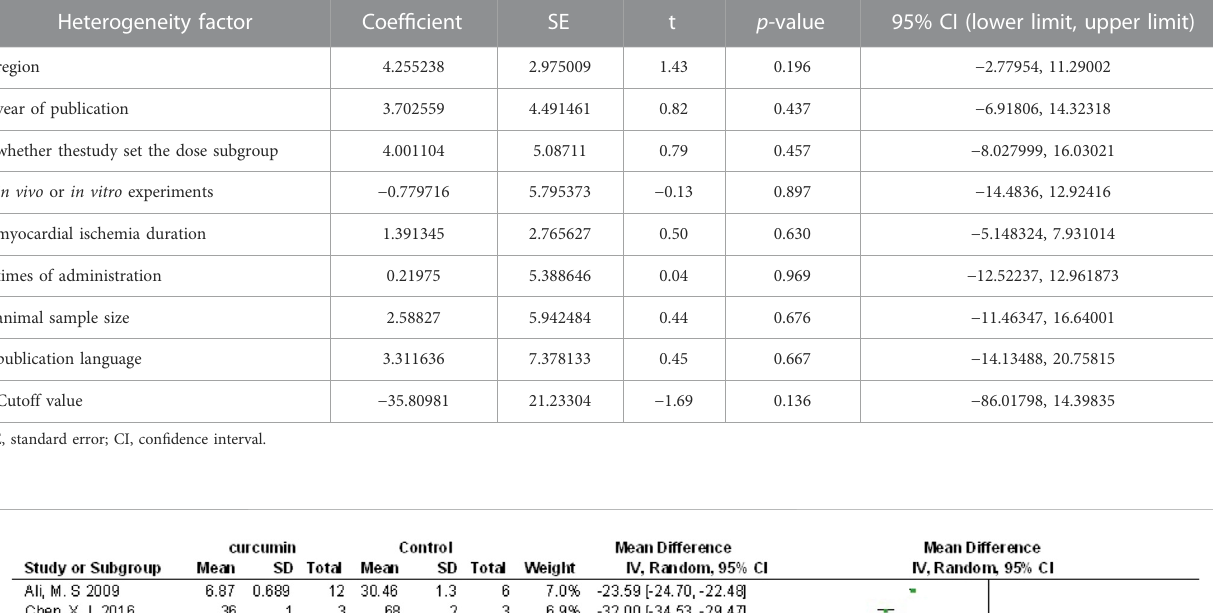
TABLE 5 Meta-regression analysis of potential sources of animal studies heterogeneity.